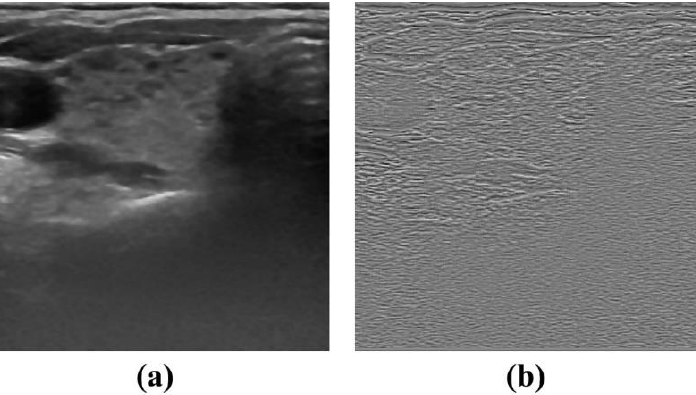
Figure 2. NLM denoising results using default standard deviation value ( 𝛿 = 20) for ( a ) denoised ultrasound image and ( b ) residual image.